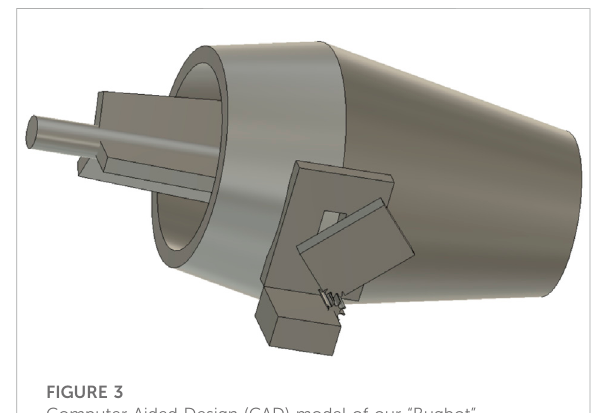
FIGURE 3 Computer Aided Design (CAD) model of our “ Bugbot ”